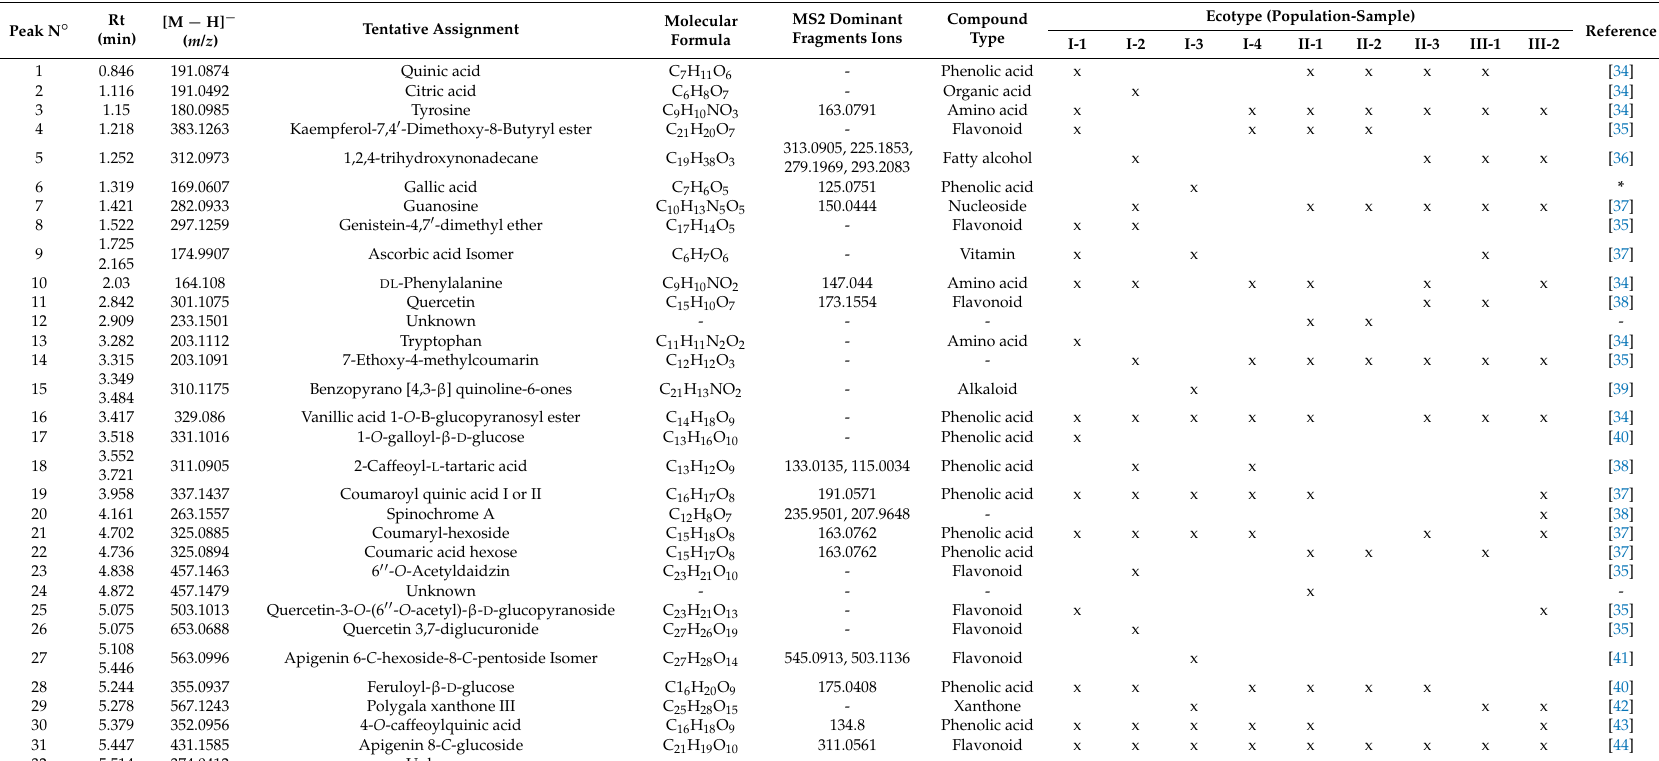
Table 2. Compounds in wild Piquin chili populations identified by